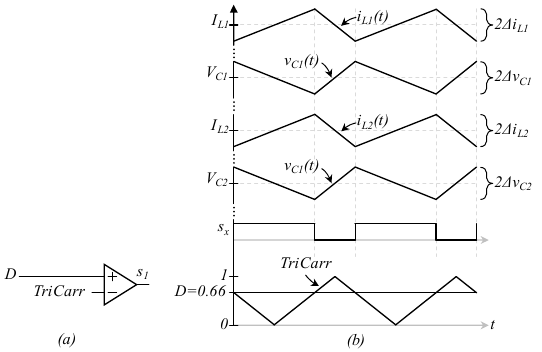
Figure 2. Pulse width modulation (PWM) scheme of the series-capacitor boost converter. The operation of the converter produces two different switching states or equivalent circuits, Figure 3a shows the equivalent circuit of the converter when s x = 1 , both tran- sistors are closed, and diodes are reversely polarized ( s 1n whit V C1 and s 2n with V C1 +V C2 ). Figure 3. (a) Switching state when s 1 =1 and s 2 =1 , (b) Switching state when s 1 =0 and s 2 =0 . Those switching states lead to two different mathematical models; by following the Kirchhoff voltage law (KVL) and the Kirchhoff current law (KCL), the mathematical model of the circuit shown in Figure 3a is given by (1)–(2). 1 1 L